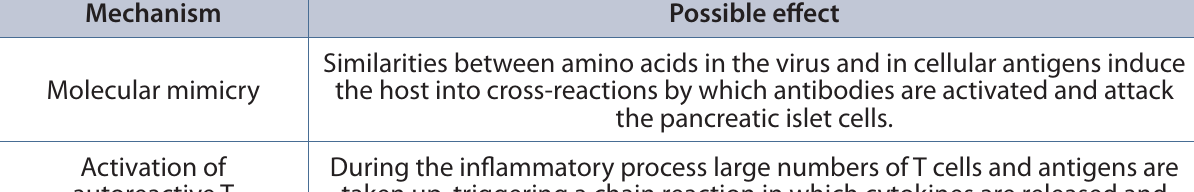
Table 2. Immune mechanisms that are possibly involved in the development of T1D Mechanism Possible effect Molecular